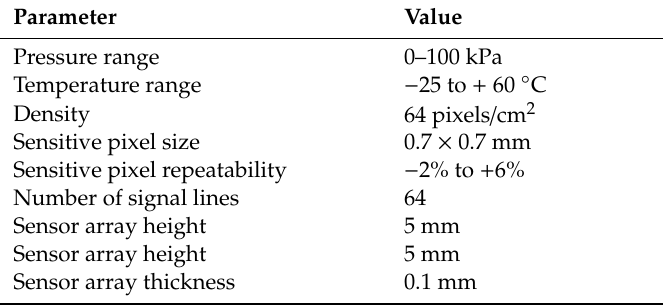
Figure 3. Self-made experimental system. ( a ) Pressure data acquisition system; ( b ) letter shape tactile image samples collected by this system. Table 2. Parameter details of the sensor array applied in the